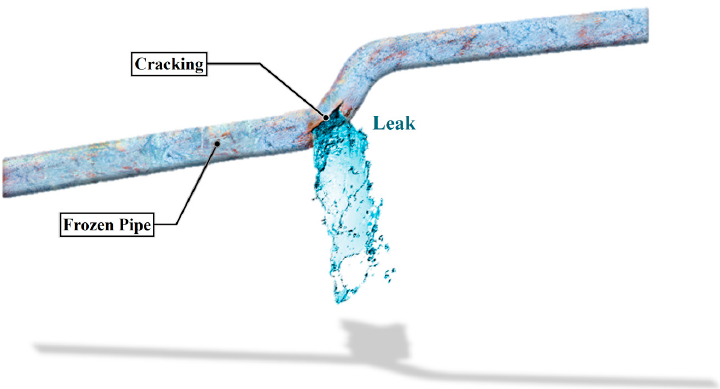
Figure 1. Cracking in pipes caused by volume expansion of water.